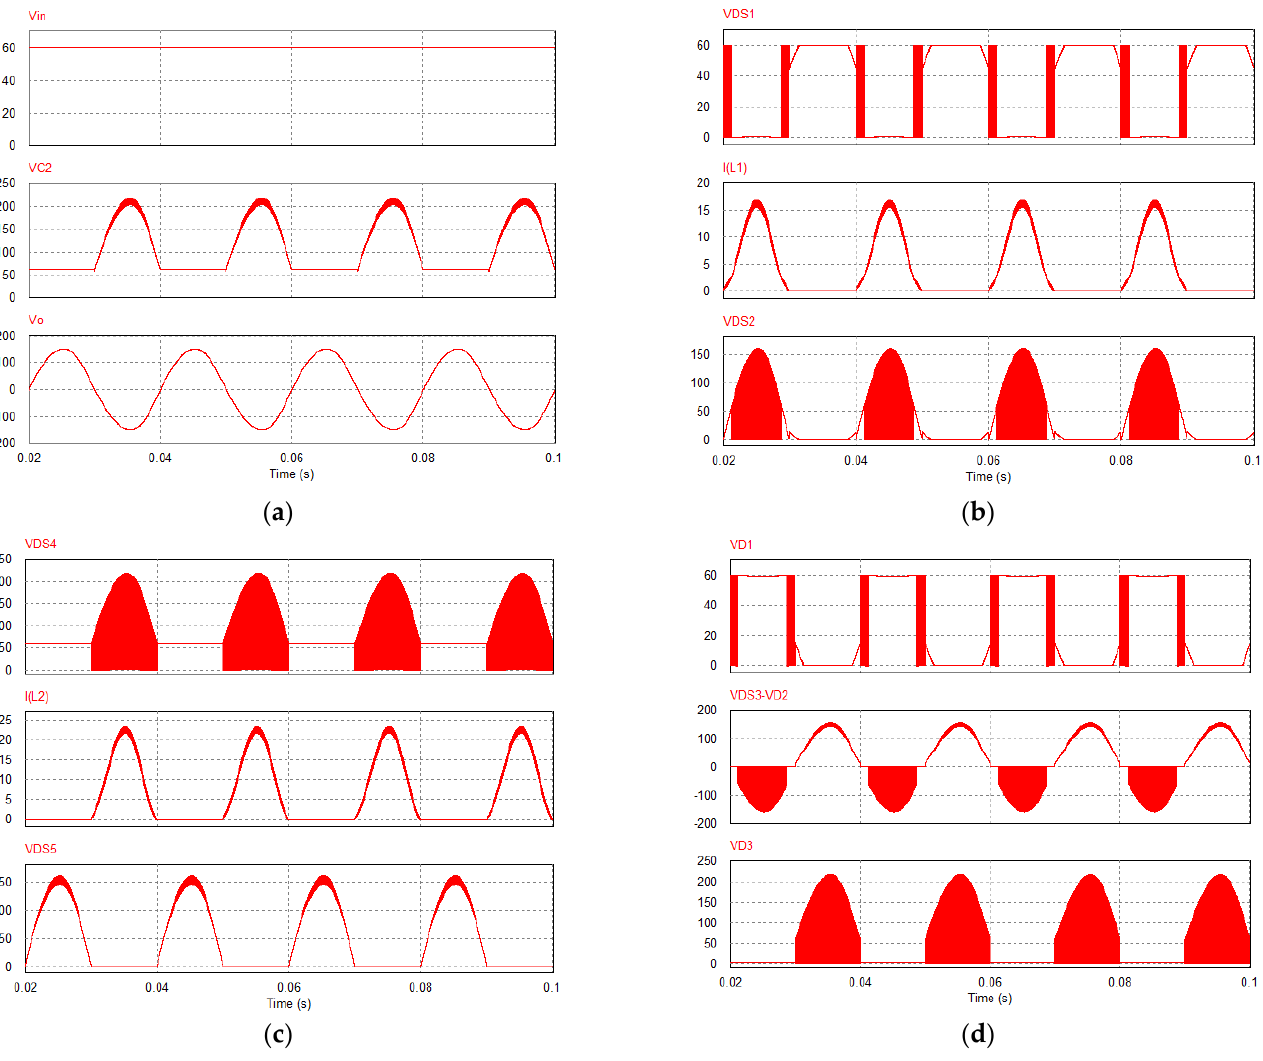
Figure 6. Simulation results with V in = 60 V: ( a ) the input, output and capacitor C 2 voltages, ( b ) the voltage stress on switches S 1 , S 2 , and the current of inductor L 1 , ( c ) the voltage stress on switches S 4 , S 5 , and the current of inductor L 2 , and ( d ) the voltage stress on diodes D 1 , D 2 , D 3 and the voltage stress on switch S 3 .